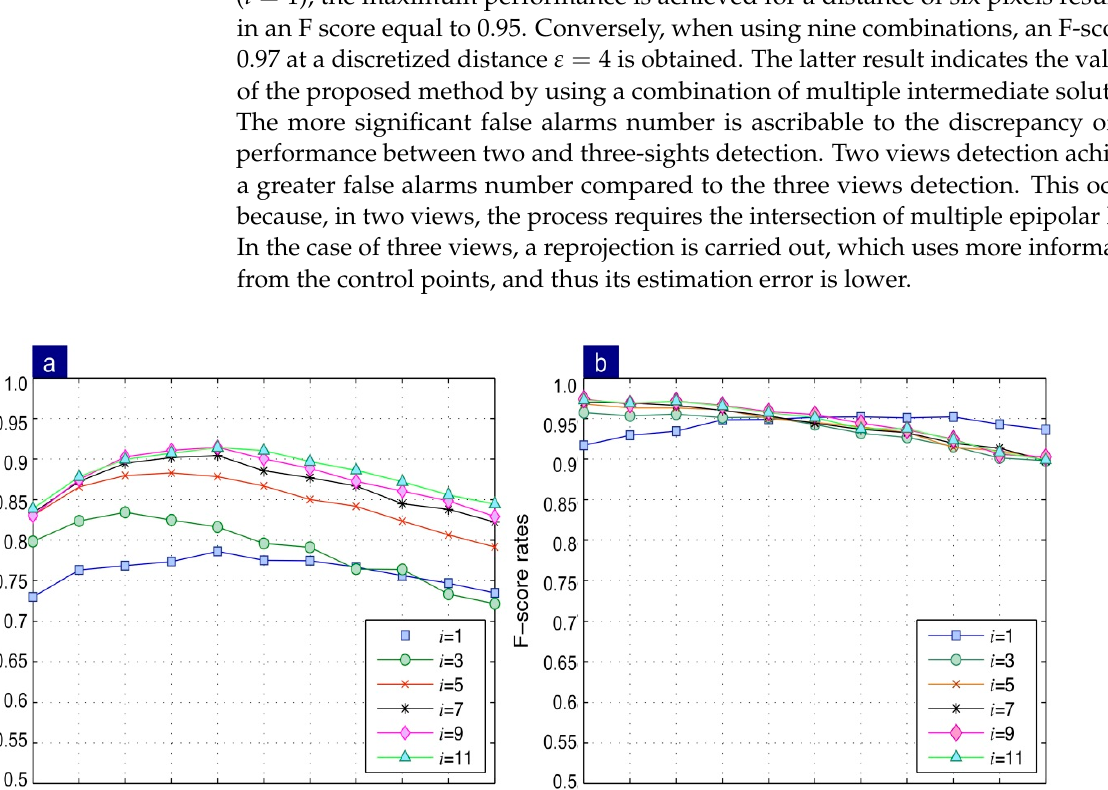
Table 1. Performance c omparison between NNDR, BIGC, and TRIGC methods: real matching set. Method